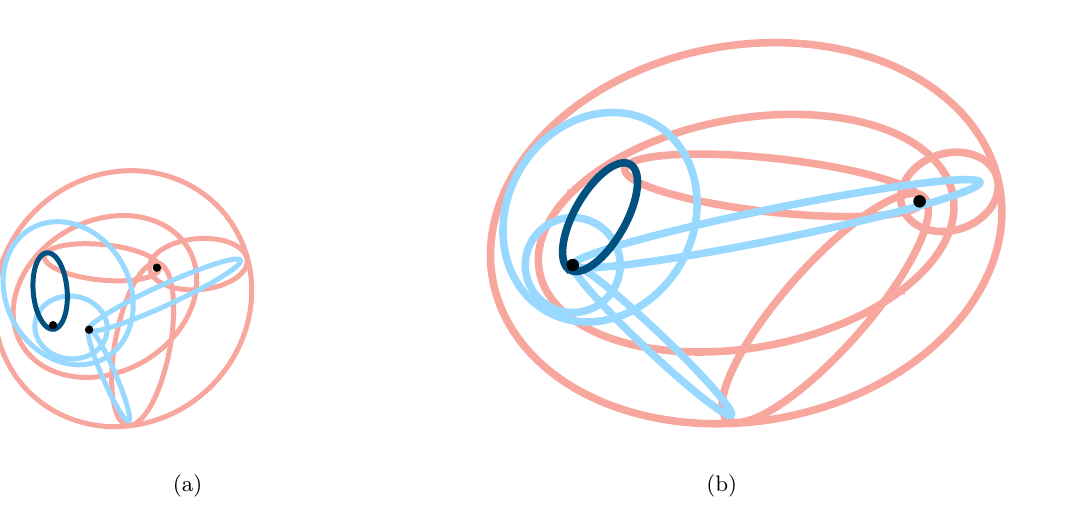
Figure 8. The ten E-surfaces of the hexagon configuration 1L6P.VIII (cf. section 4.3) in spatial momentum space in two Lorentz frames. Only the intersections of ellipses in the same color result in poles in the E-surface residues. The groups of each color can therefore be parameterised inde- pendently. Here, we can choose the groups’ sources to be the foci, which for massless propagators are simply given by − p (cf. appendix B). The groups and their sources are E + , E + , E + , E + , E + i 13 23 43 53 63 with − p , E + with − p and E + with − p . In the rest frame of p + p in (b) two , E + , E + , E + 3 6 1 1 6 61 62 64 65 21 sources collide and we can merge their respective groups. In (a) we use a different parameterisation for each group. Curiously, the residues in the red group locally sum up to zero. This is not further investigated in this